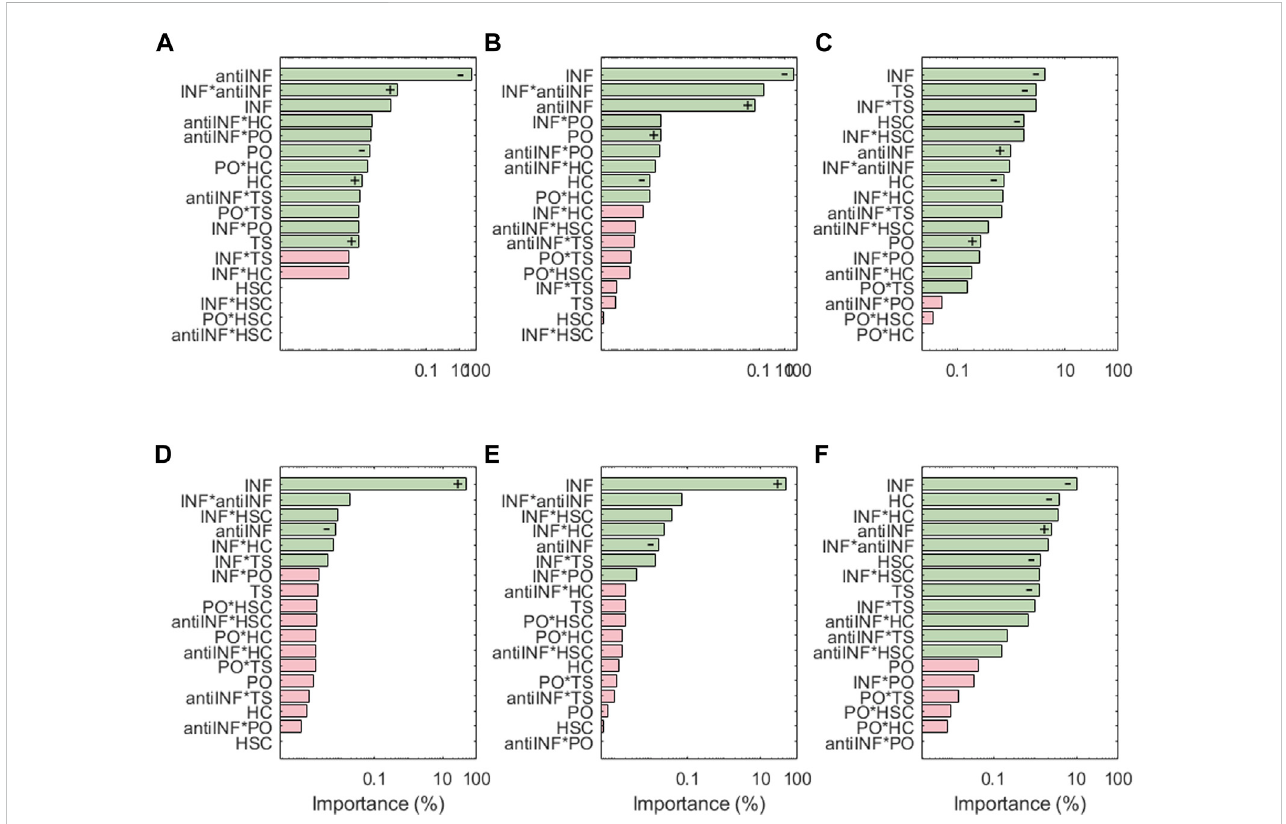
FIGURE 7 Paretochartsof (A) AP1, (B) CITED2, (C) FOXO, (D) HIF2a, (E) NF- κ Band (F) Sox9.Signi fi cantinteractionsarecoloredingreen( α =0.05),non-signi fi cantin pink.+: positive in fl uence; − : negative in fl